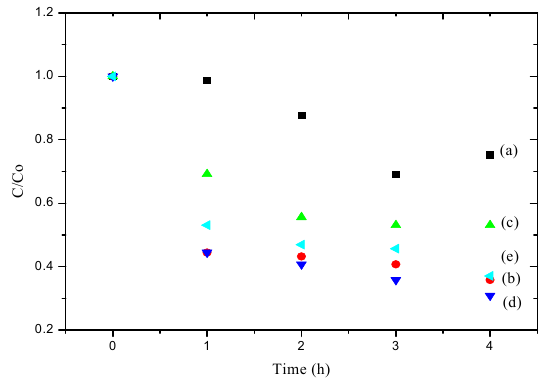
Figure 12. Relationship between C / C 0 and reaction time in hours for Simazine decomposition catalyzed by ( a ) Cu ‐ 00; ( b ) Cu ‐ 01; ( c ) Cu ‐ 02; ( d ) Cu ‐ 03; and ( e ) Cu ‐ 04 samples under UV irradiation.